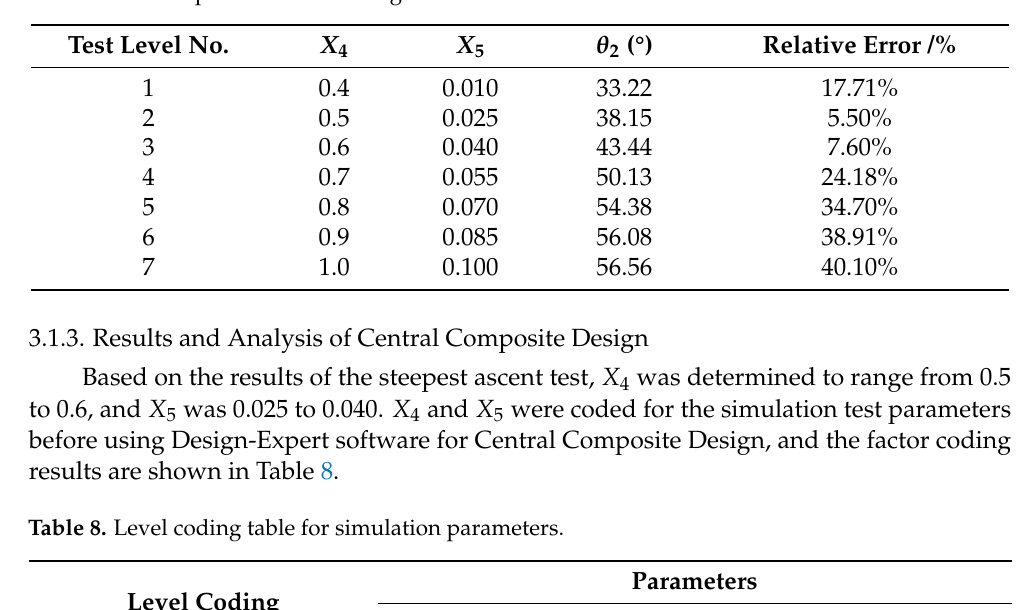
Table 7. The steepest ascent test design scheme and results.